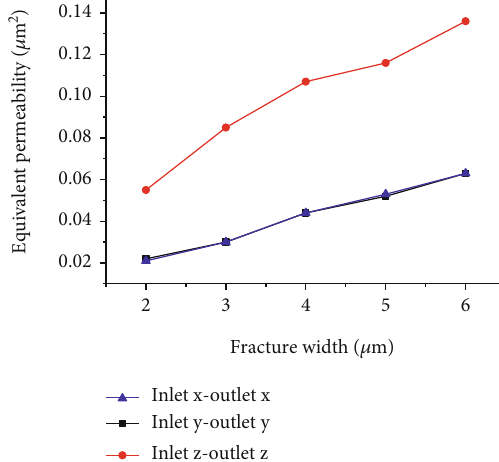
Figure 6: Flow fl ux of each inlet and outlet with di ff erent fracture widths.